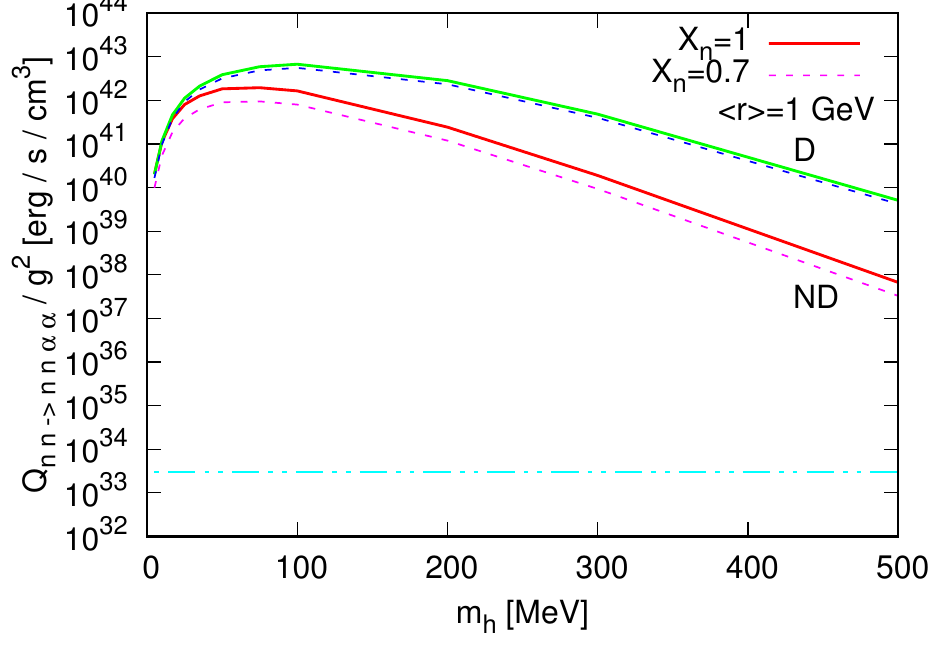
Figure 1 . Energy loss rate due to Goldstone boson emission from nuclear bremsstrahlung processes nn ! nn(cid:11)(cid:11) divided by the Higgs portal coupling g 2 , for various light Higgs boson mass m h . The rates are calculated in the non-degenerate (ND) and degenerate (D) limits, for proto-neutron star core temperature T = 30 MeV, neutron fraction X n = 1 (solid) and 0 : 7 (dashed), respectively. For all m h values we assume the radial (cid:12)eld vacuum expectation value is h r i = 1 GeV. Also shown is Ra(cid:11)elt’s analytical criterion on the energy loss rate per unit volume Q X in eq. (5.1)